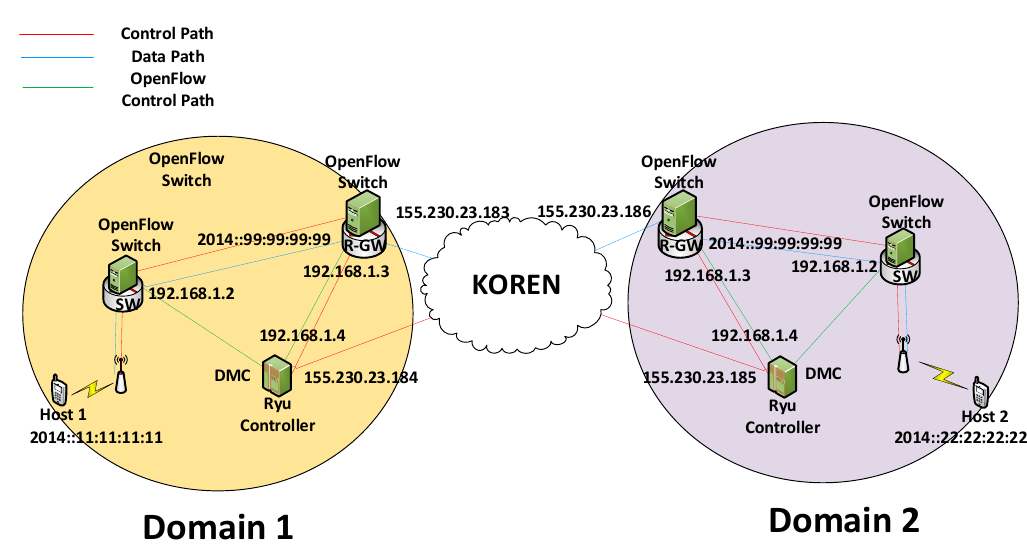
Figure 22. Validation testbed network configuration.